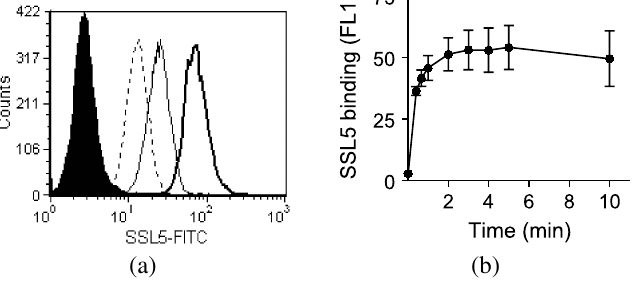
Fig. 1. SSL5 binding characteristics to HL-60 leukemia cells. (a) HL-60 cells were incubated with 0 (black histogram), 1 (dashed line), 3 (thin continuous line) or 10 (thick continuous line) µg/ml SSL5-FITC. Binding was assayed 30 min after incubation at 4 ◦ C. Results are representative of three independent experiments. (b) For binding kinetics, HL-60 cells were treated with 10 µg/ml SSL5-FITC at 37 ◦ C. At several time points fluorescence was measured. Data are mean values ± SEM of three independent